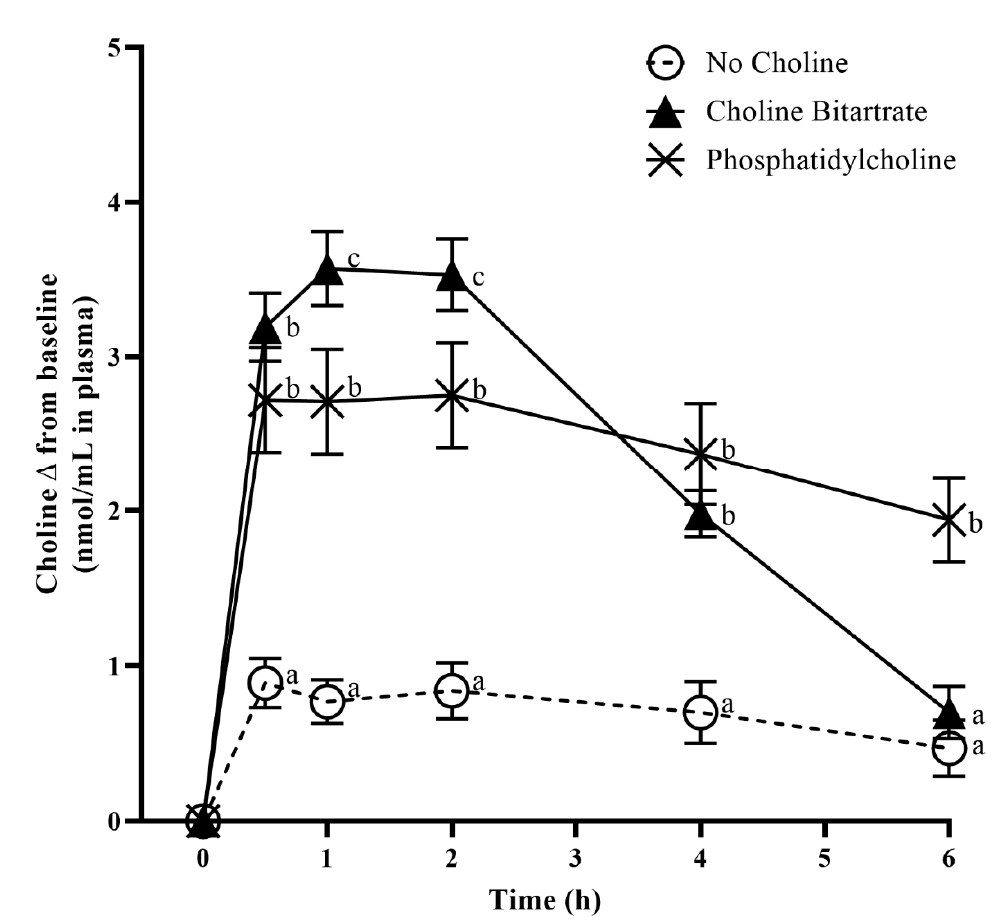
Figure 5. Effects of the study meals on plasma free choline change from 0 min study-baseline across